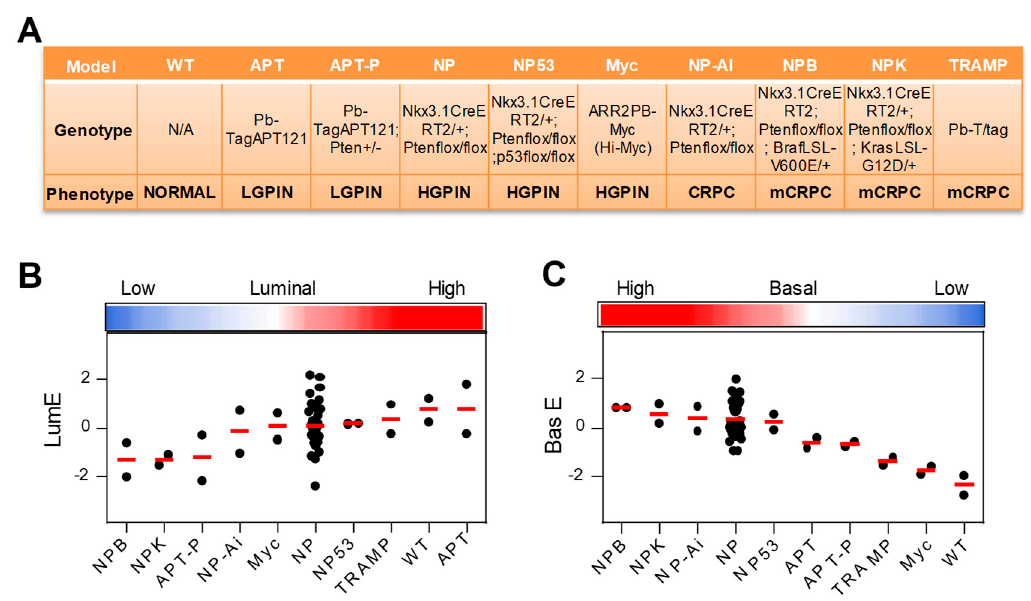
Figure 7. Application of metagene enrichment to genetically engineered mouse models (GEMMs) of prostate cancer. ( A ) Genotype and phenotypes of mouse models included in the study. WT, normal prostate; LGPIN and HGPIN, low-grade and high-grade prostate intraepithelial neoplasia; PC, prostate cancer; CRPC, castration-resistant prostate cancer; mCRPC, metastatic CRPC. For details see Supplementary Figure S14B,C LumE ( B ) and BasE ( C ) score distribution in mouse models.